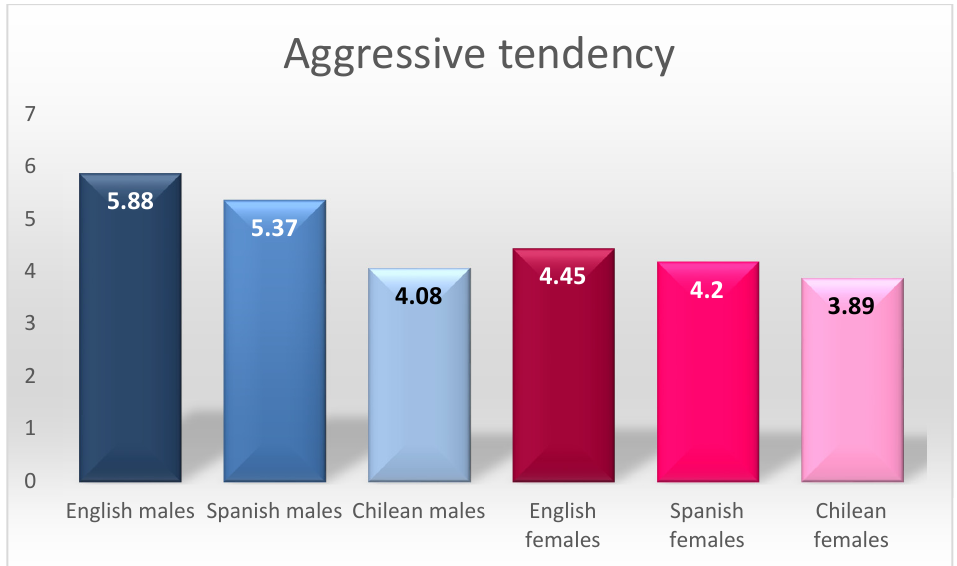
Figure 1. Summary of differences in aggressive tendency.